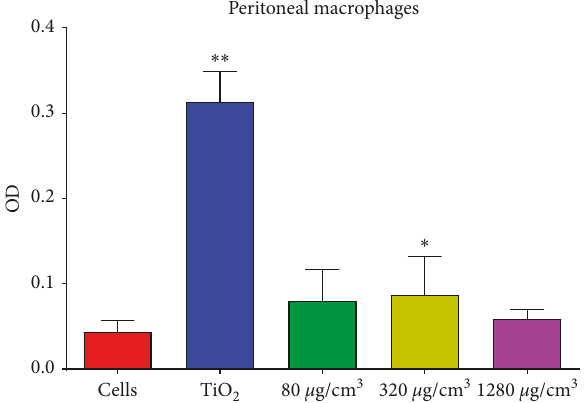
Figure 7: Nitric oxide production on peritoneal macrophages by volcanic ash after 24 hours. Macrophages were exposed to 80 µ g/cm 3 (green), 320 µ g/cm 3 (yellow), and 1280 µ g/cm 3 (purple) of volcanic ash and 400 µ g/cm 3 of titanium dioxide (blue). The negative control was cells without any treatment